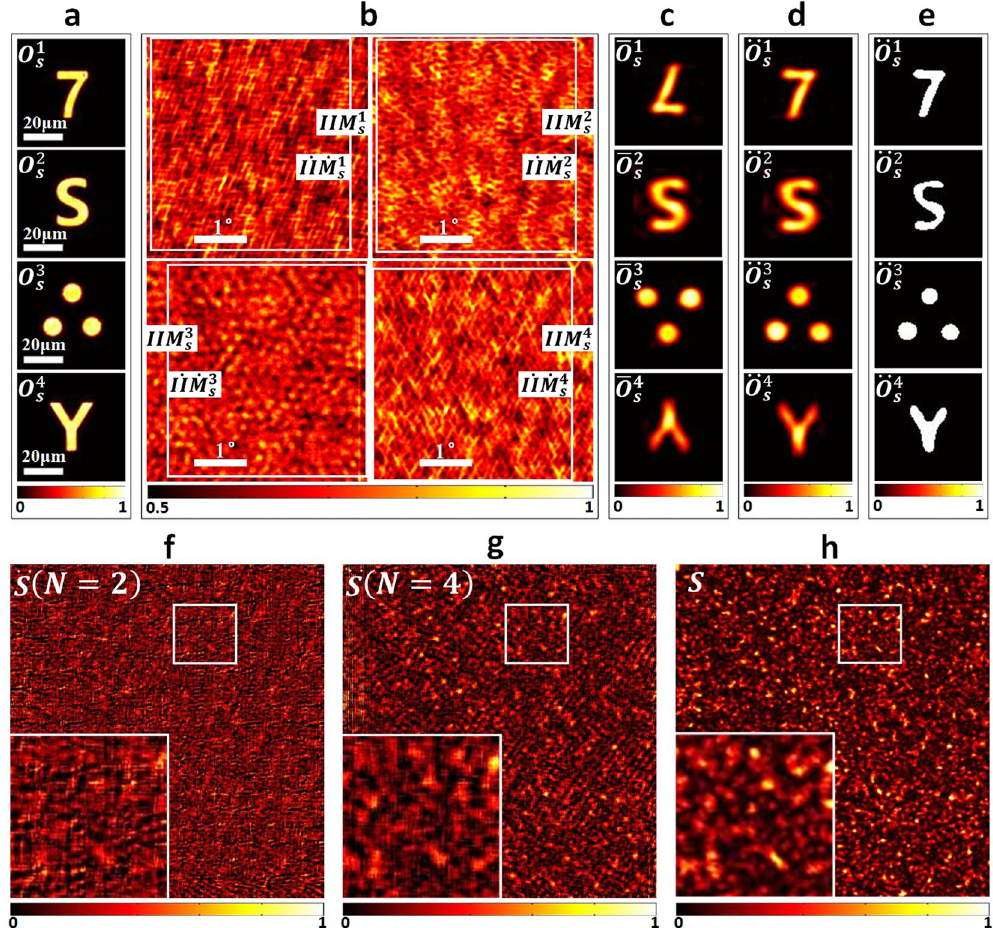
Figure 3. ( a ) Training targets, =  O i ( 1, 2, , 4) si . ( b ) Collected IIMs of training targets, =  IIM i ( 1, 2, , 4) si . The regions lined in white are the aligned IIMs, = (cid:31) (cid:31) (cid:30) IIM i ( 1, 2, , 4) si . ( c ) Phase retrieval results of training targets, =  O i ( 1, 2, , 4) si . ( d ) Phase retrieval results with corrected orientations, =  ̈ O i ( 1, 2, , 4) si . ( e ) Binarized phase retrieval results with correct orientations. The thresholds are set as 0.436, 0.592, 0.549 and 0.291, respectively. ( f ) Estimated speckle pattern, ̈ S , using two training targets ( N = 2), O speckle pattern, ̈ S , using the four training targets ( N = 4). ( h ) Ground truth of speckle pattern S